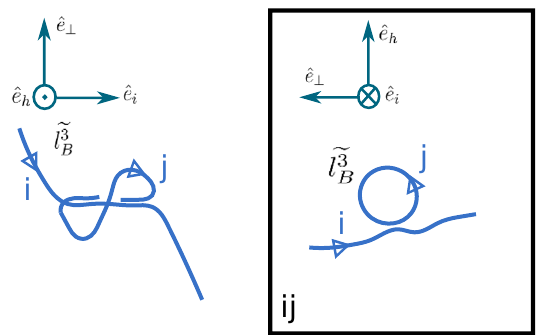
Figure 51 . Lift of l B that contains an exchange.